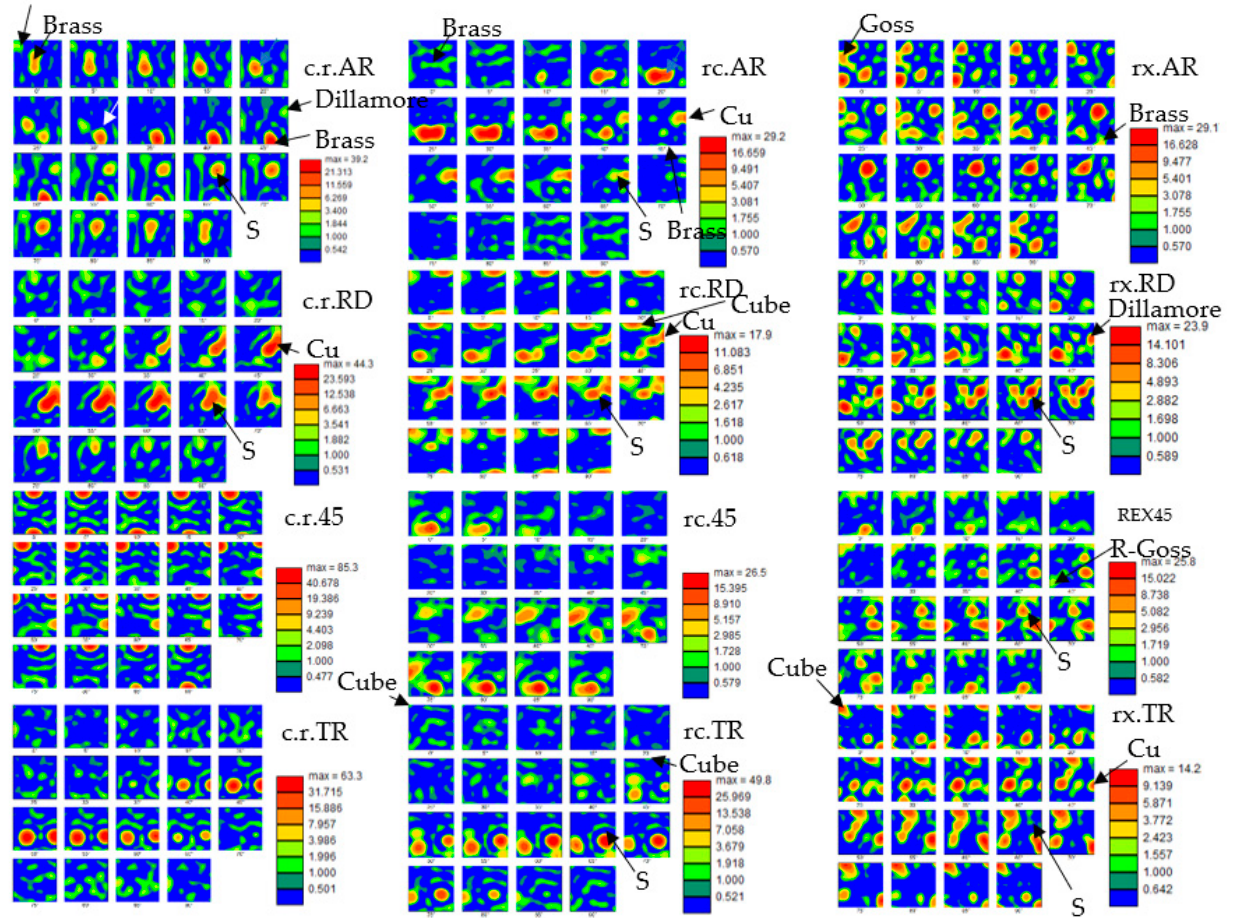
Figure 13. ODFs of the examined samples.